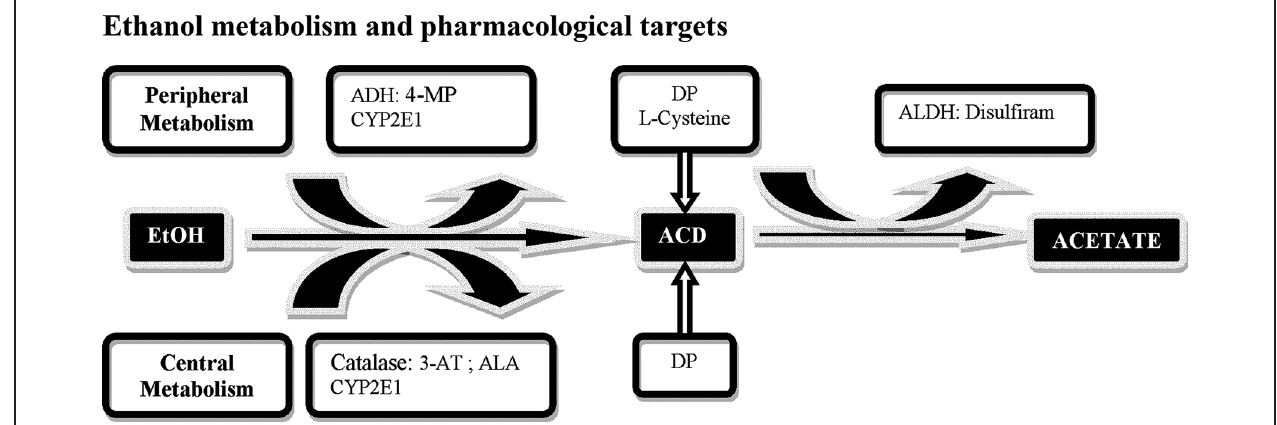
FIGURE 1 | Schematic representation of central and peripheral ethanol (EtOH) metabolic pathways and possible pharmacological targets. EtOH is metabolized into acetaldehyde (ACD) through several pathways, the main enzyme being alcohol dehydrogenase (ADH), inhibited by 4-methylpyrazole (4-MP); CYP2E1 and catalase H 2 O 2 system inactivated by 3-aminotriazole